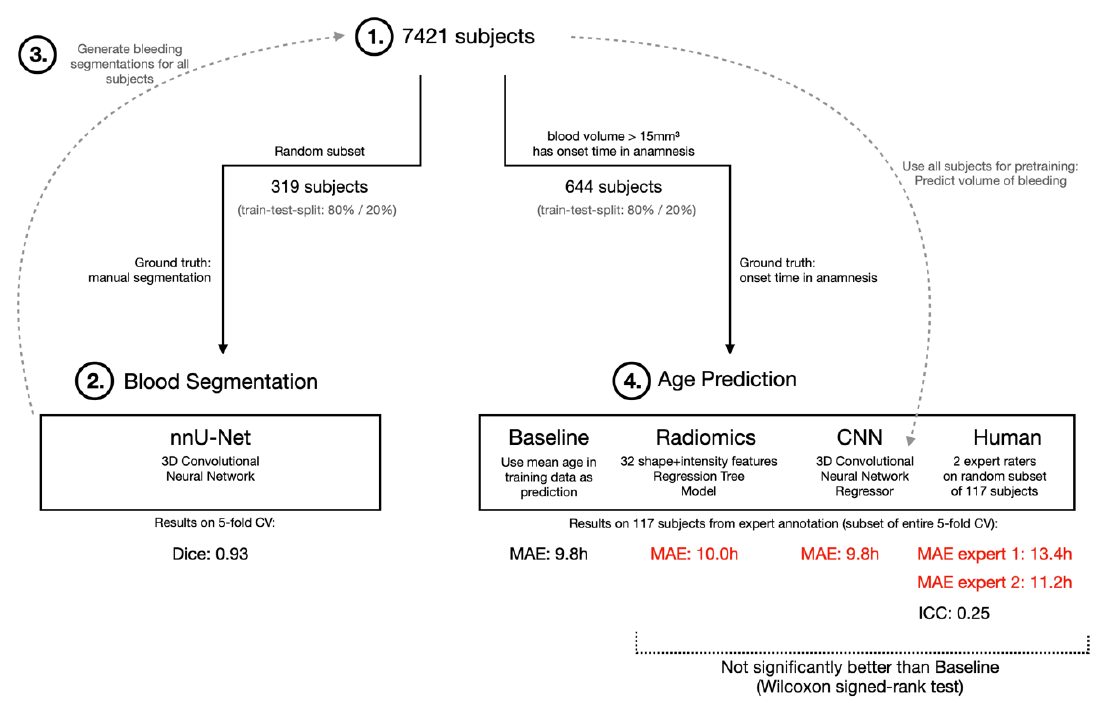
Figure 1. Flowchart of inclusion of patients. Overview study design: On a subset of the original study population (1.) a hematoma segmentation model is trained (2.) which is used to generate hematoma segmentations for the entire study population (3.) Then, the radiomics-, CNN-, and human-based age prediction is performed (4.) (MAE: Mean absolute error; CNN: Convolutional Neural Network, nnU-Net: Neural network for semantic segmentation).